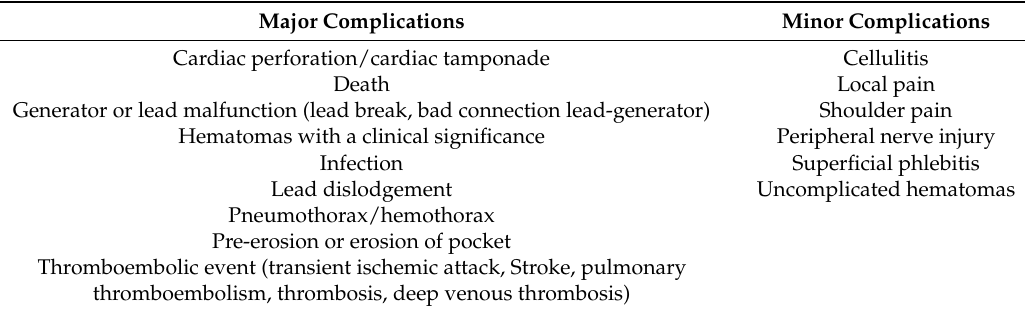
Table 1. Major and minor